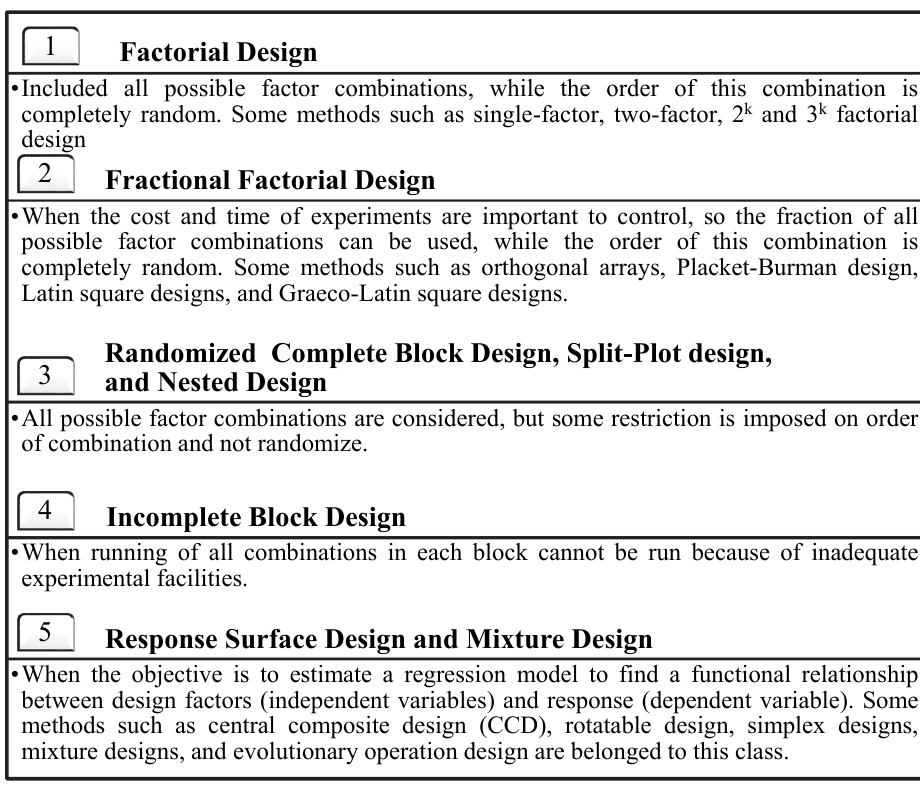
Fig. 8. Classification of experimental